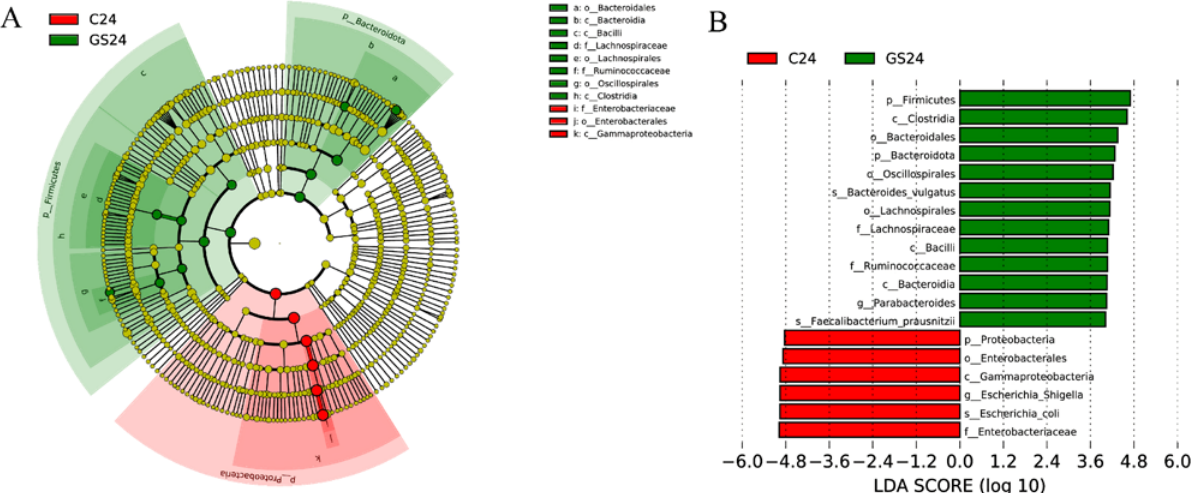
Figure 5. LEfSe analysis ( A ) LEfSe evolutionary branching diagram (red nodes indicate enrichment in C24, while green nodes indicate enrichment in G24) ( B ) Histogram of LDA value distribution (LDA > 4).